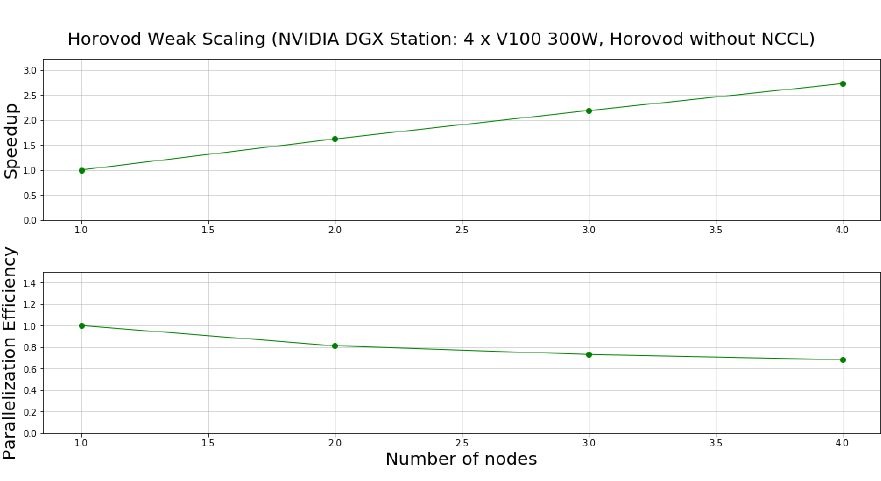
Figure 5. Table showing scaling e ffi ciency